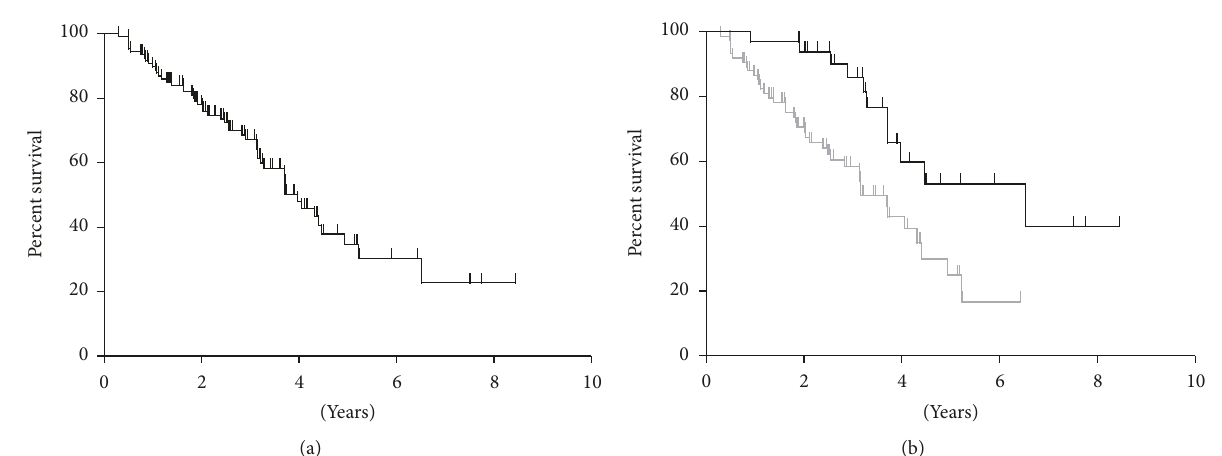
Figure 1: Kaplan-Meier plots of the overall survival from time of diagnosis of metastatic disease for (a) the entire 108-patient study population and (b) the study population divided into a cohort of patients who only experienced diffuse disease progression (gray line) and a cohort patients who experienced oligoprogression or oligometastases with progression at least once in their disease